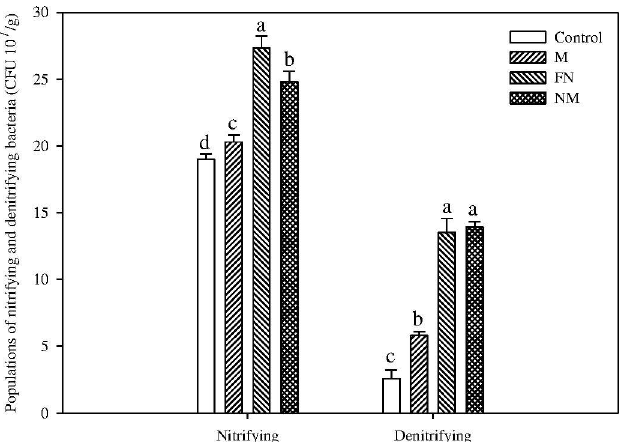
Fig 4. Effect of CMV as GM on the populations of nitrifying and denitrifying bacteria in paddy soil at maturity stage of rice plants. Bars indicate standarderror (n = 3). Different letters indicate significantly different means at P < 0.05.